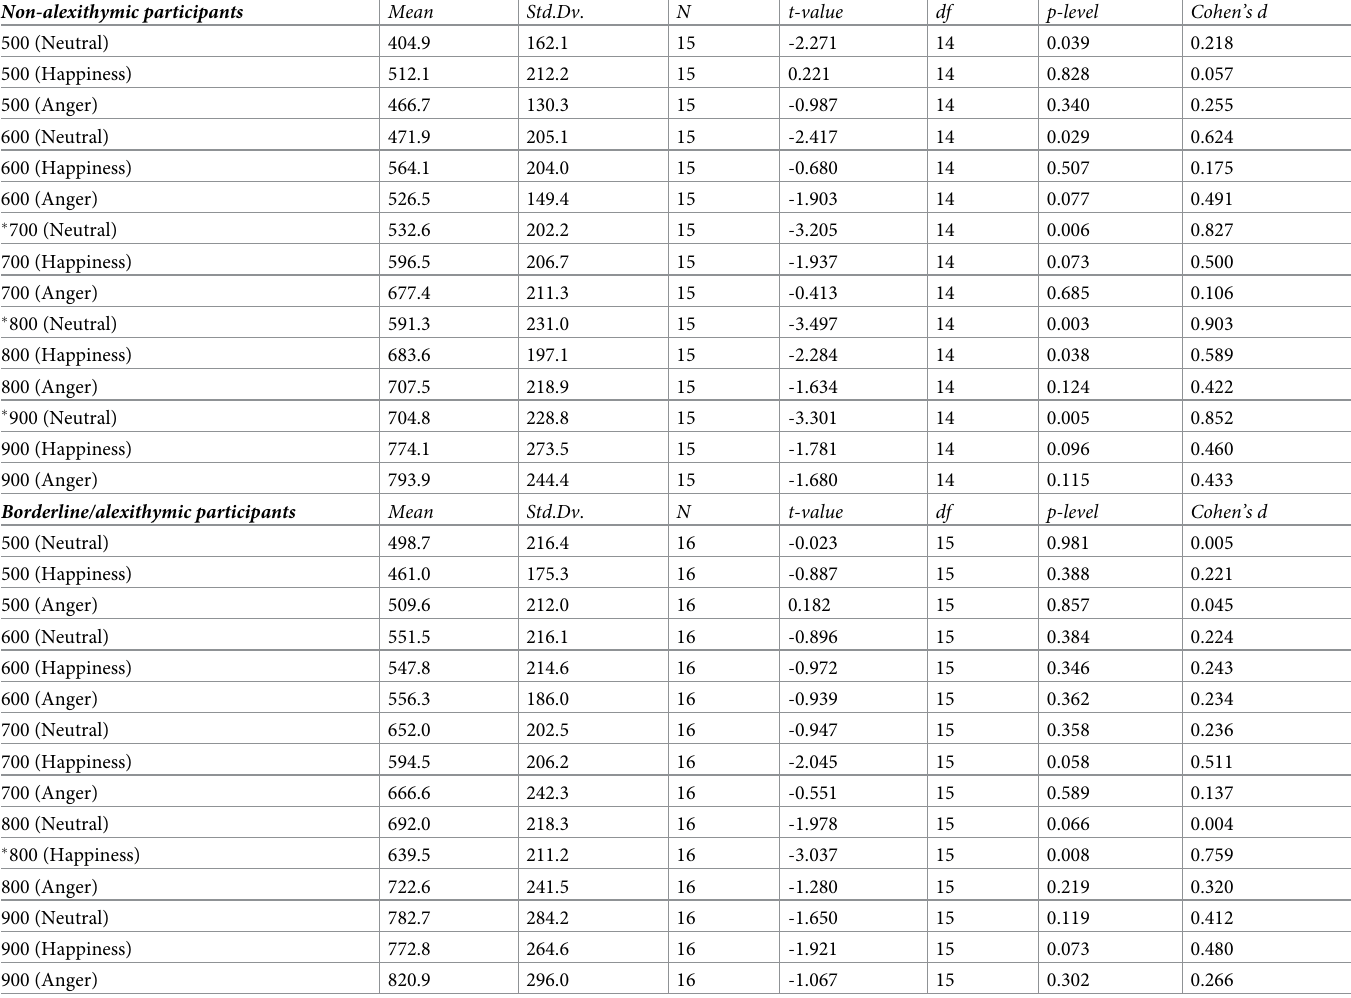
Table 2. One sample t-test analysis for single means (500–900 ms) of the time reproduction of non-alexithymic and borderline/alexithymic individuals for the three facial